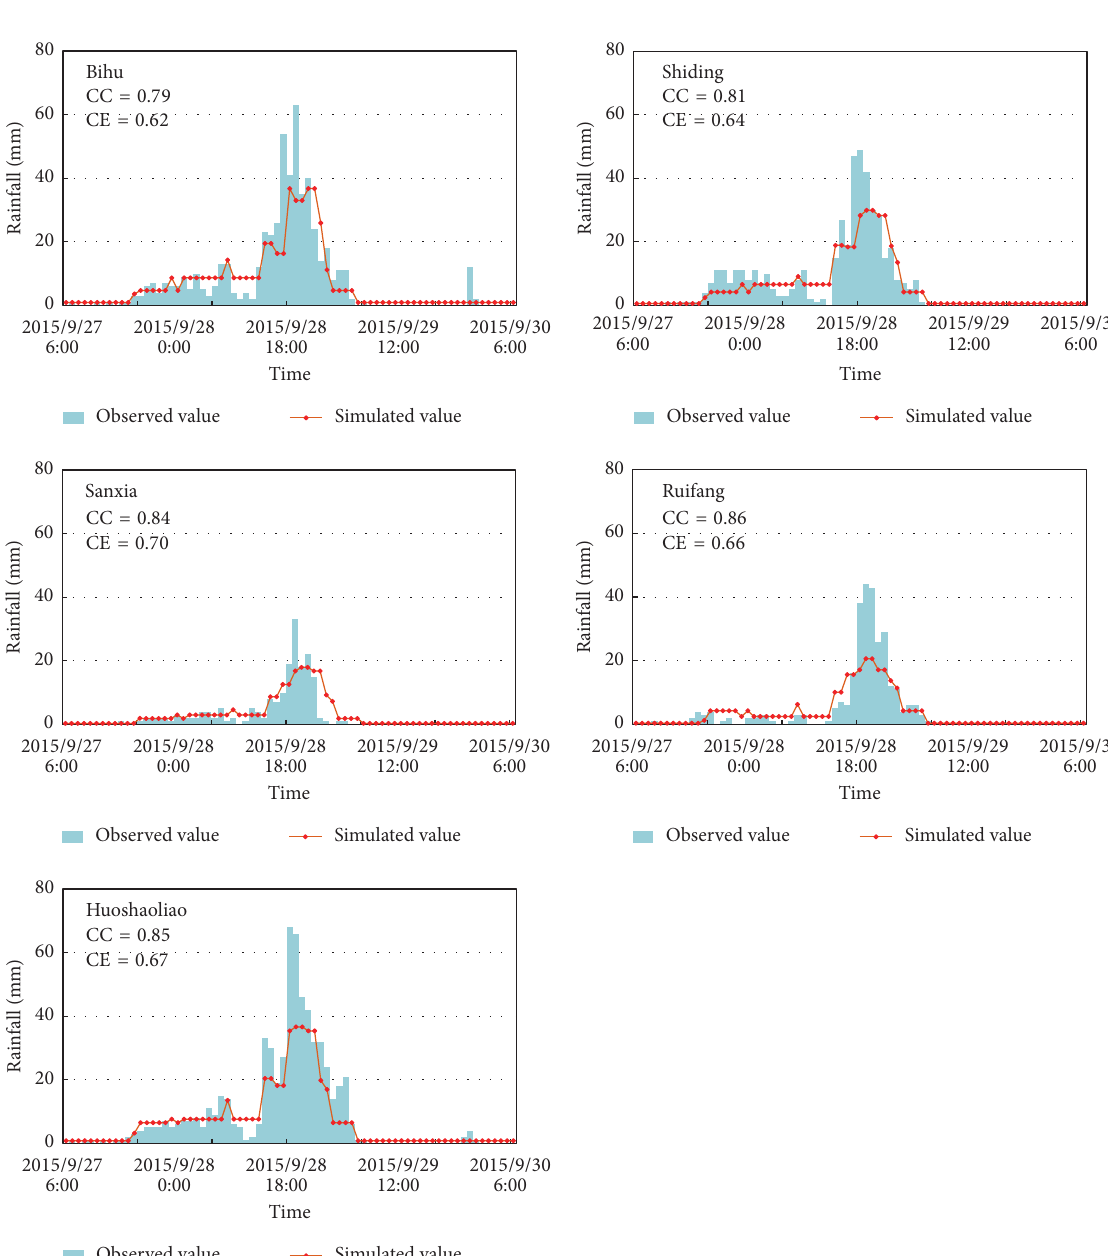
Figure 5: Results of hourly rainfall forecast during Typhoon Dujuan